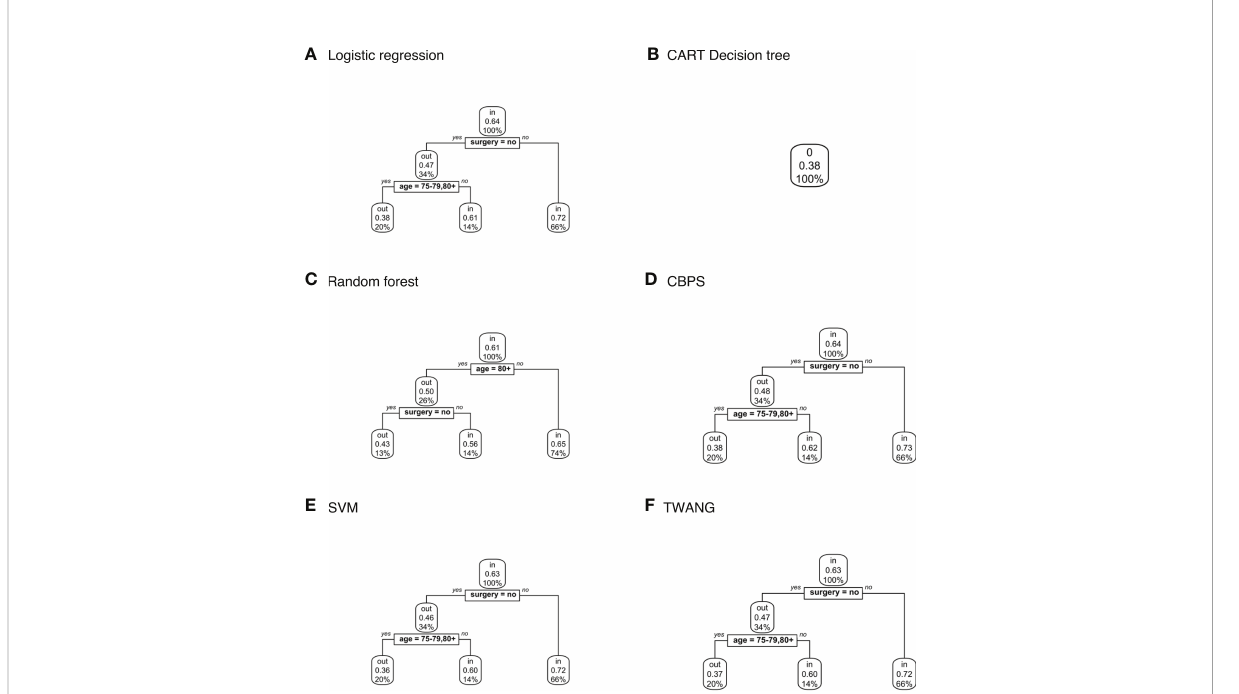
FIGURE 4 Population-level explainer decision trees for glioblastoma data comparing chemotherapy vs. radiation therapy outcomes. Trees classify subjects as matched ( “ in ” ) or unmatched ( “ out ” ) given observed features using propensity scores estimated by (A) logistic regression; (B) CART decision tree; (C) random forest; (D) covariate balancing propensity scores; (E) support vector machines; and (F) the Toolkit for Weighting and Analysis of Nonequivalent Groups. Each node lists the probability of the corresponding classi fi cation for the set of features listed above it and the percentage of subjects that exhibit that